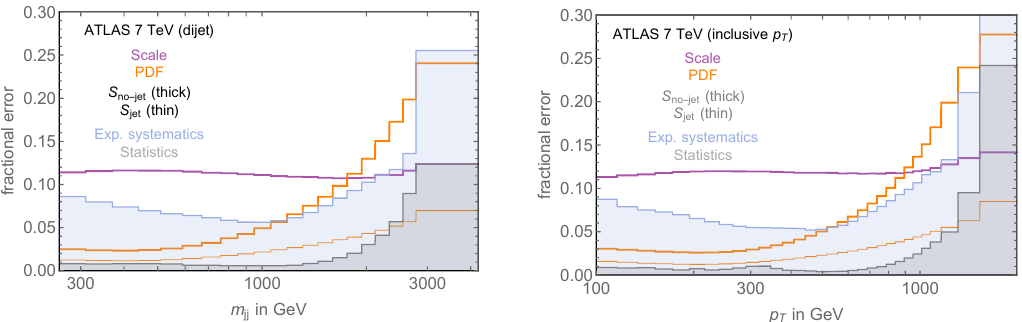
Figure 1 . Scale and PDF uncertainties for the central rapidity bin of the ATLAS dijet (left) and inclusive p T (right) analyses. Similar results holds for less central bins and for the ana- logue CMS